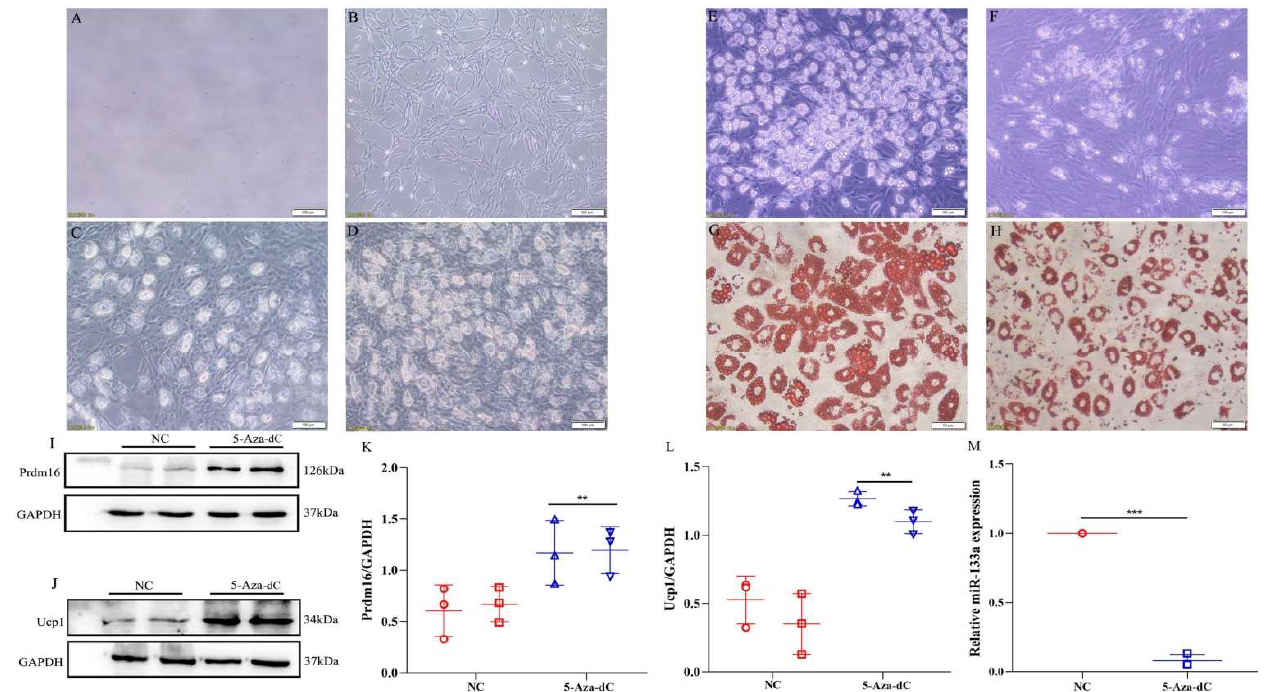
Figure 5. Detection of Prdm16, Ucp-1, and miR-133a expression in adipocytes ( A – D ). Primary adipocyte culture for the 0–12th day ( A – D , Bar = 100 µm). ( E ) The growth of cells on the 12th day after DNA demethylation treatment; ( F ) The growth of cells on the 12th day ( E , F , Bar = 100 µm); ( G ) Oil red staining of cells on the 12th day after DNA demethylation treatment; ( H ) Oil red staining of cells on the 12th day ( G , H , Bar = 50 µm). ( I , J ) Expression of Prdm16 and Ucp1 in adipocytes using Western blotting. ( K , L ) Normalized intensity of Prdm16 and Ucp1 relative to GAPDH is presented as the mean ± SD (n= 3). ( M ) The expression levels of miR-133a in fully differentiated adipocytes treated with 5-aza. *** p < 0.001, ** p < 0.01, compared with controls. NC, normal control; 5-Aza-dC,